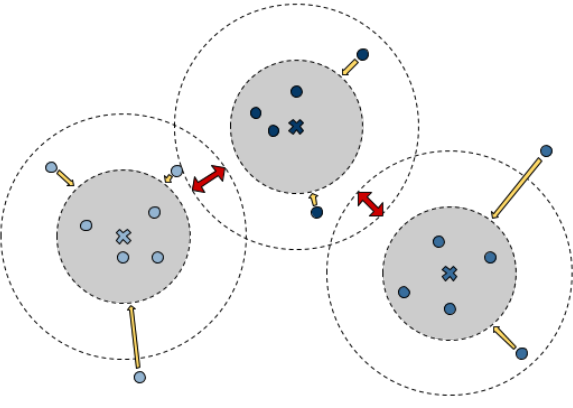
Figure 5. Illustration of the forces acting on the pixels to form the clusters (image adopted from [36]): With the variance term (yellow arrows), the pixels are drawn in the direction of the cluster mean (crosses). The distance term (red arrows) pushes the different clusters apart. Both forces are only active as long as the threshold values are not reached (inner circle for the cluster variance and outer circle for the